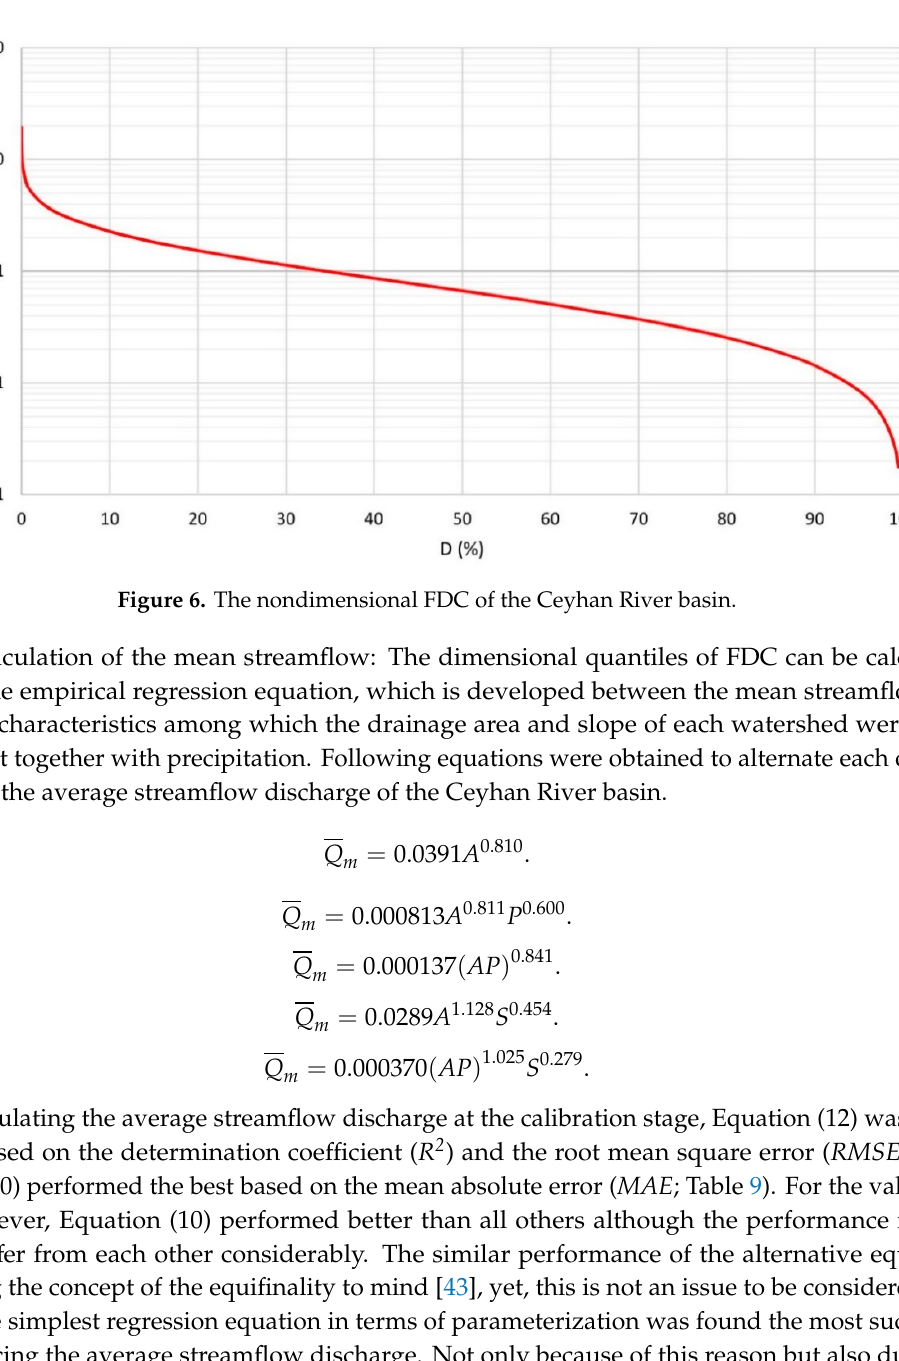
Table 9. Performance criteria calculated for the watershed average streamflow.